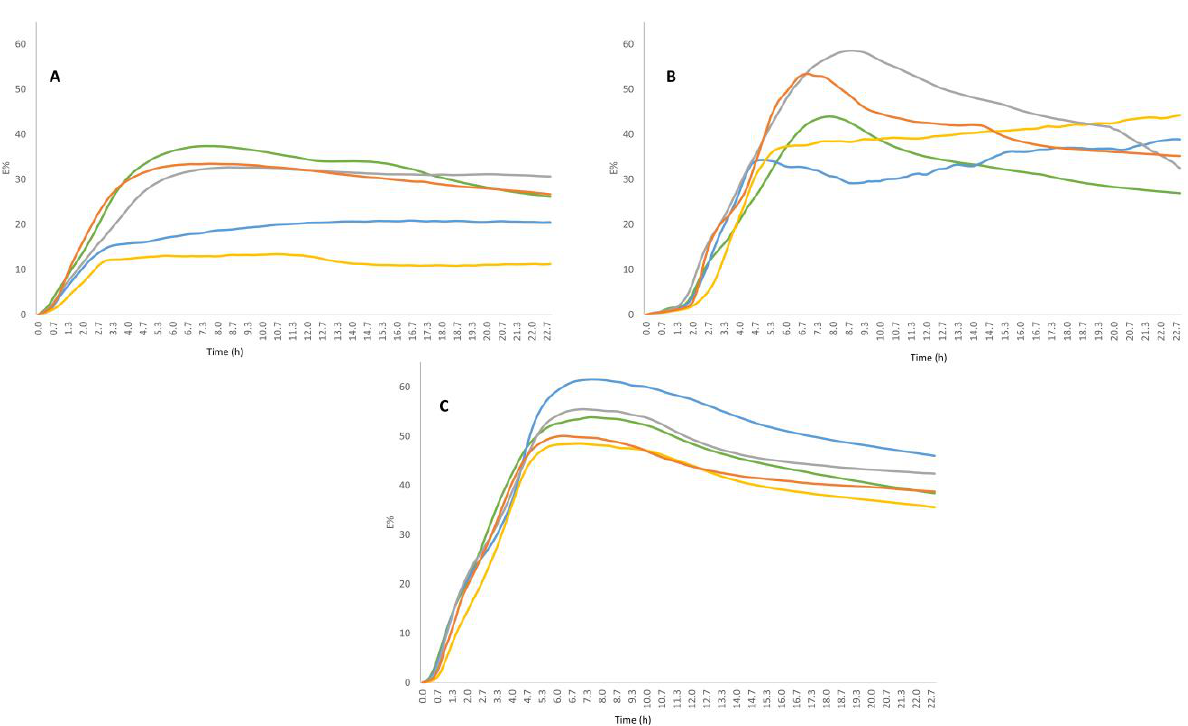
Figure 1. Impedometric curves of strains fed with the five different sugars (different colours). Each curve corresponds to the average curve from three independent experiments. ( A ) L. rhamnosus 1019, ( B ) L. paracasei 2333, ( C ) L. bulgaricus 1932.